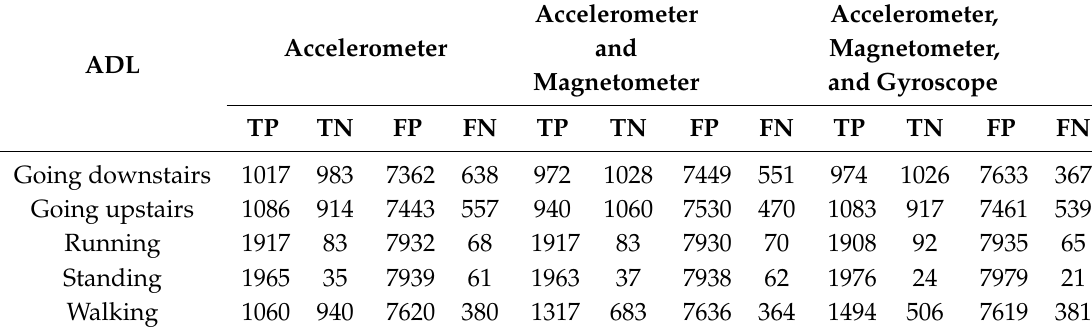
Table 6. Confusion matrix values of ADL identification using AdaBoost with the decision tree implemented with the SMILE framework (TP = True Positive; TN = True Negative; FP = False Positive; FN = False Negative).